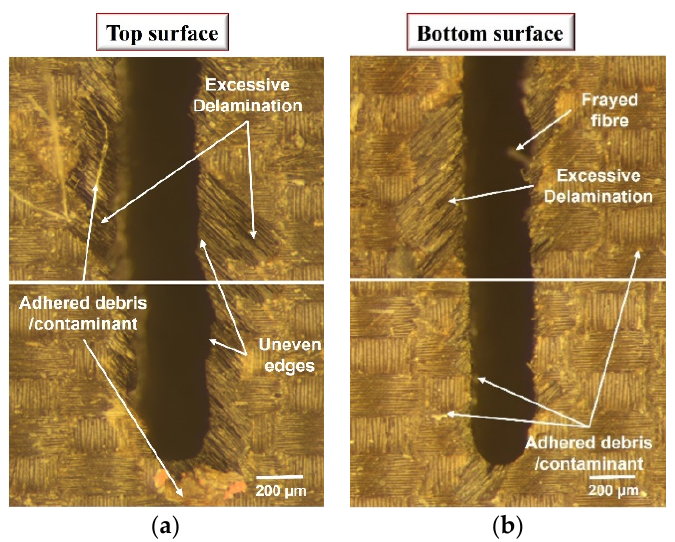
Figure 7. Optical micrographs of the kerf machined using Compeed wire in Test 6 at the ( a ) top and ( b ) bottom surface.